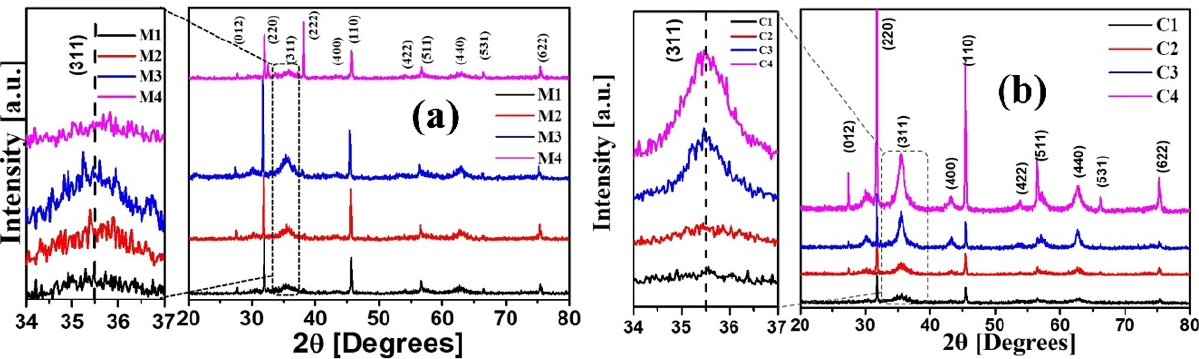
Figure 3. XRD pattern of MNPs synthesised at increasing molarities; ( a ) from M1 to M4 and ( b ) from C1 to C4.